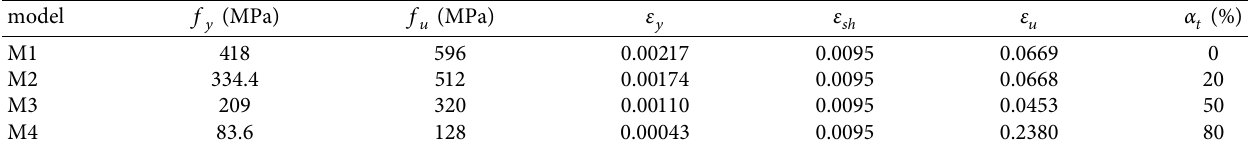
Figure 12: Te cyclic loading pattern applied to the used model [1]. Table 6: Strength reduction of the steel ring contact element.